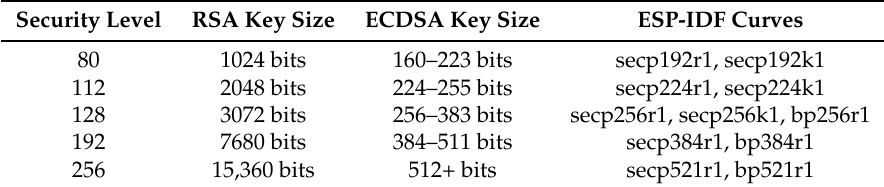
Table 2. Comparable security levels for RSA and